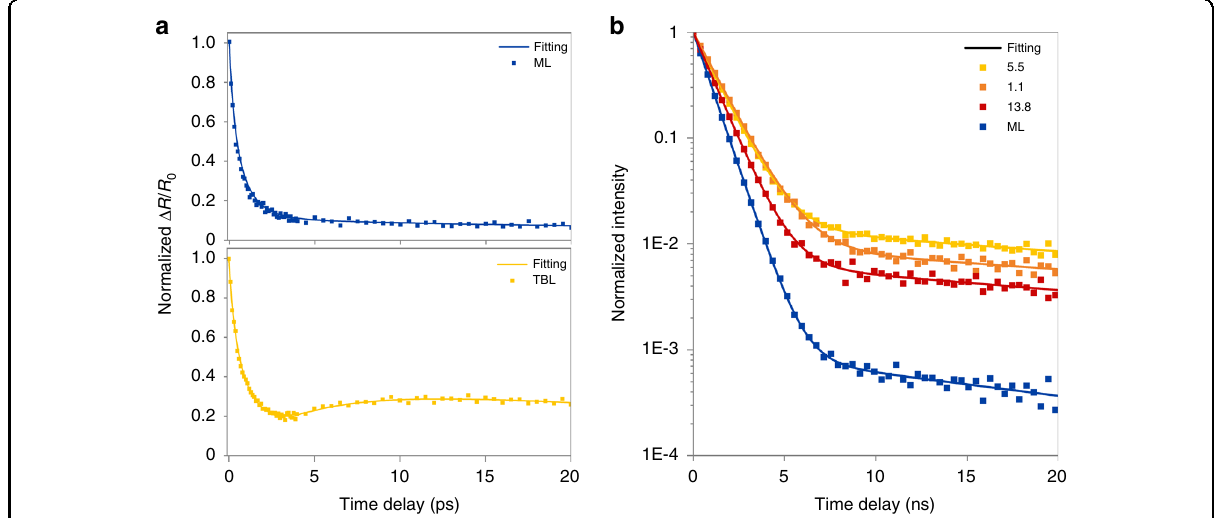
Fig. 5 Time-resolved study of WSe 2 TBLs luminescence. a The transient re fl ected absorption pump-probe detection results of WSe 2 ML (top panel) and 5.5° TBL (bottom panel) within 20 ps; solid lines represent fi ttings based on Eq. (1) (Table S1). b The fl uorescence lifetime measurements of ML (blue) and TBLs (warm colors) with various interlayer rotation angles; solid lines represent biexponential fi ttings (Table